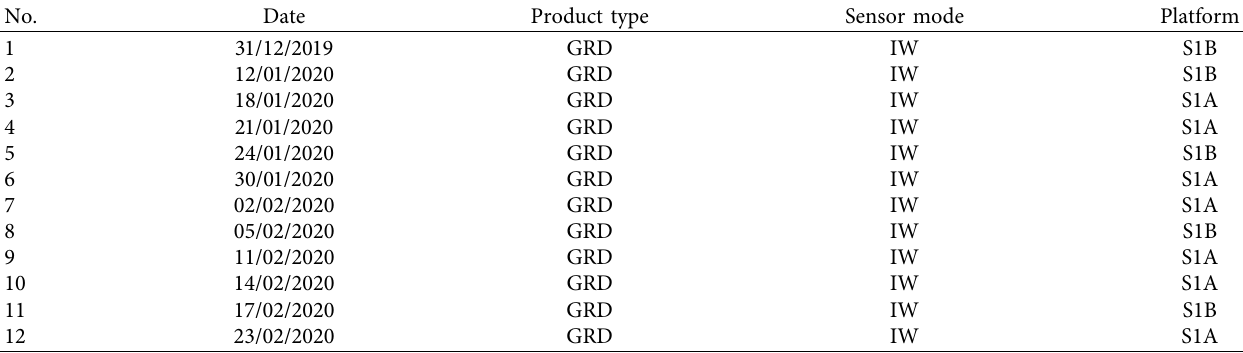
Table 3: Technical information of Sentinel-1 data for time series